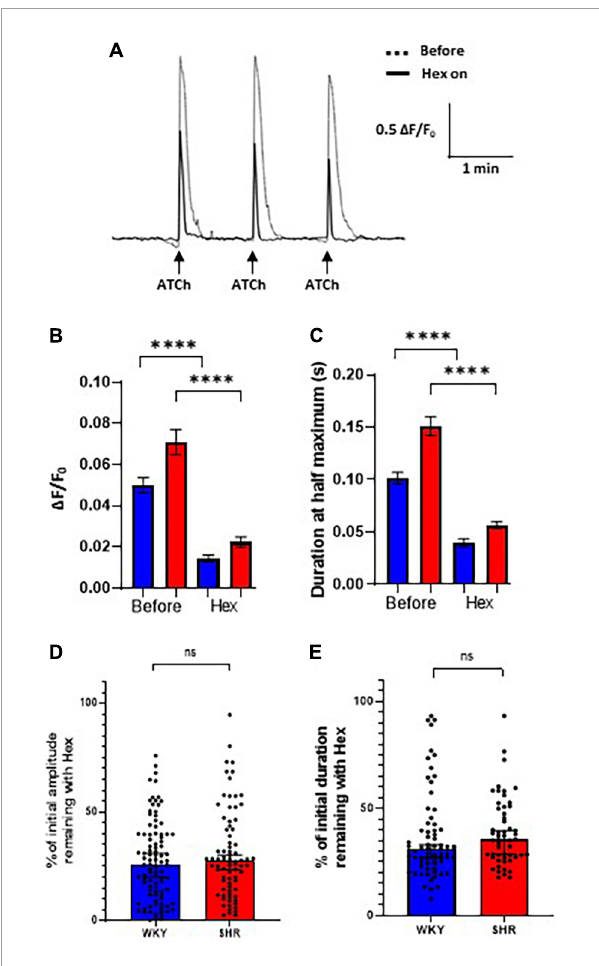
FIGURE4 Hexamethonium block of acetylthiocholine (ATCh) evoked Ca 2 + responses. Bath application of hexamethonium (300 µ M) reduced the ATCh (200 ms and 500 µ m) evoked fluorescence responses in both Wistar Kyoto (WKY) and spontaneously hypertensive rat (SHR) ganglionated plexi (GP) neurons. (A) Example traces from a WKY GP neuron before (dashed) and during (solid black) hexamethonium application in response to three local, transient ATCh applications. (B) The amplitude ( (cid:49) F/F 0 ) and (C) the duration at half maximum of responses in WKY (blue) and SHR (red) GP neurons were significantly reduced during hexamethonium application (mean ± SE; two-way ANOVA ∗∗∗∗ p < 0.0001). (D) The percentage of the initial response amplitude and (E) duration remaining after hexamethonium application in WKYs and SHRs (median ± 95% CI; Mann-Whitney test) (four WKY, 95 cells; three SHR, 67 cells). Only neurons that continued to respond with a response peak of > 0.01 (cid:49) F/F 0 during hexamethonium treatment were included in the duration analysis (C,E)